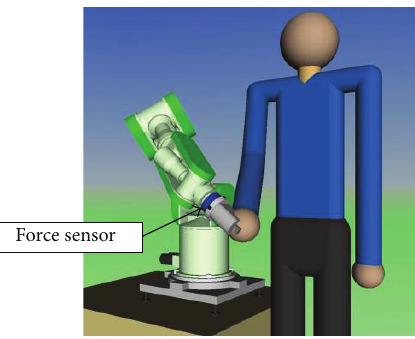
Figure 2: Image of action support manipulator.